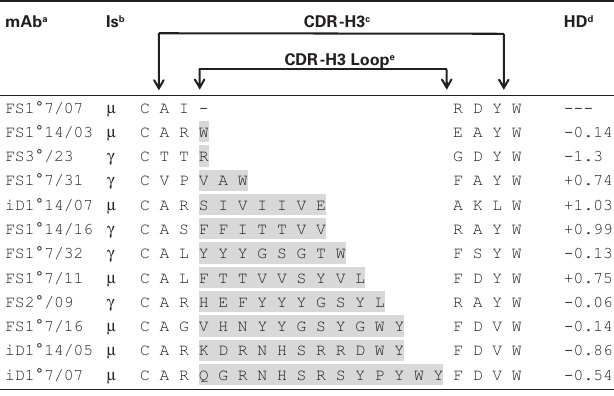
Table 3 | Exemplary representation of the spectrum of CDR-H3 lengths and average hydropathicity values of CDR-H3 loops of selected anti-phOx antibodies from D-altered ∆ D-D µ FS and ∆ D-iD mice . mAb a Is b CDR-H3 c HD d CDR-H3 Loop e FS1°7/07 µ C A I